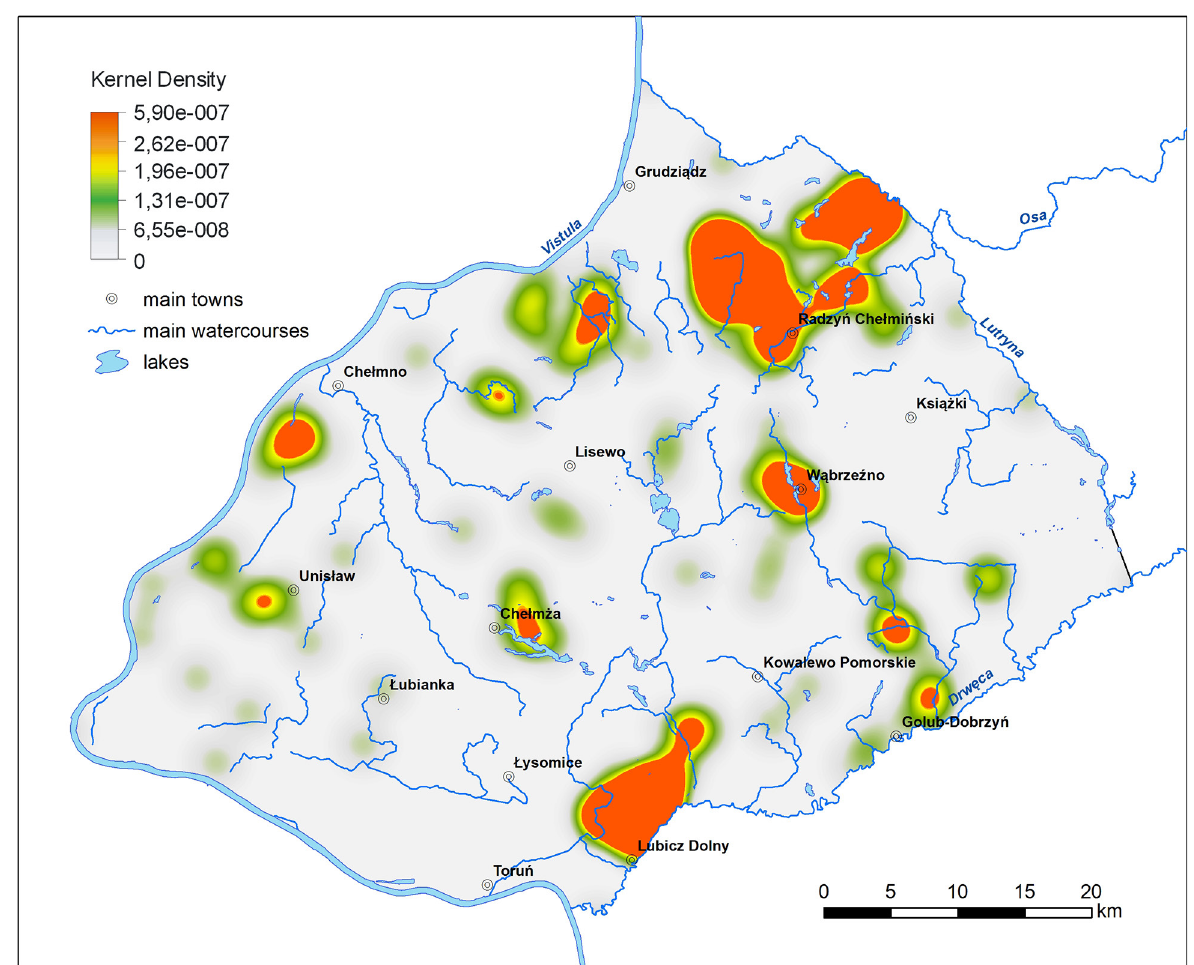
Fig. 8. Density of archaeological